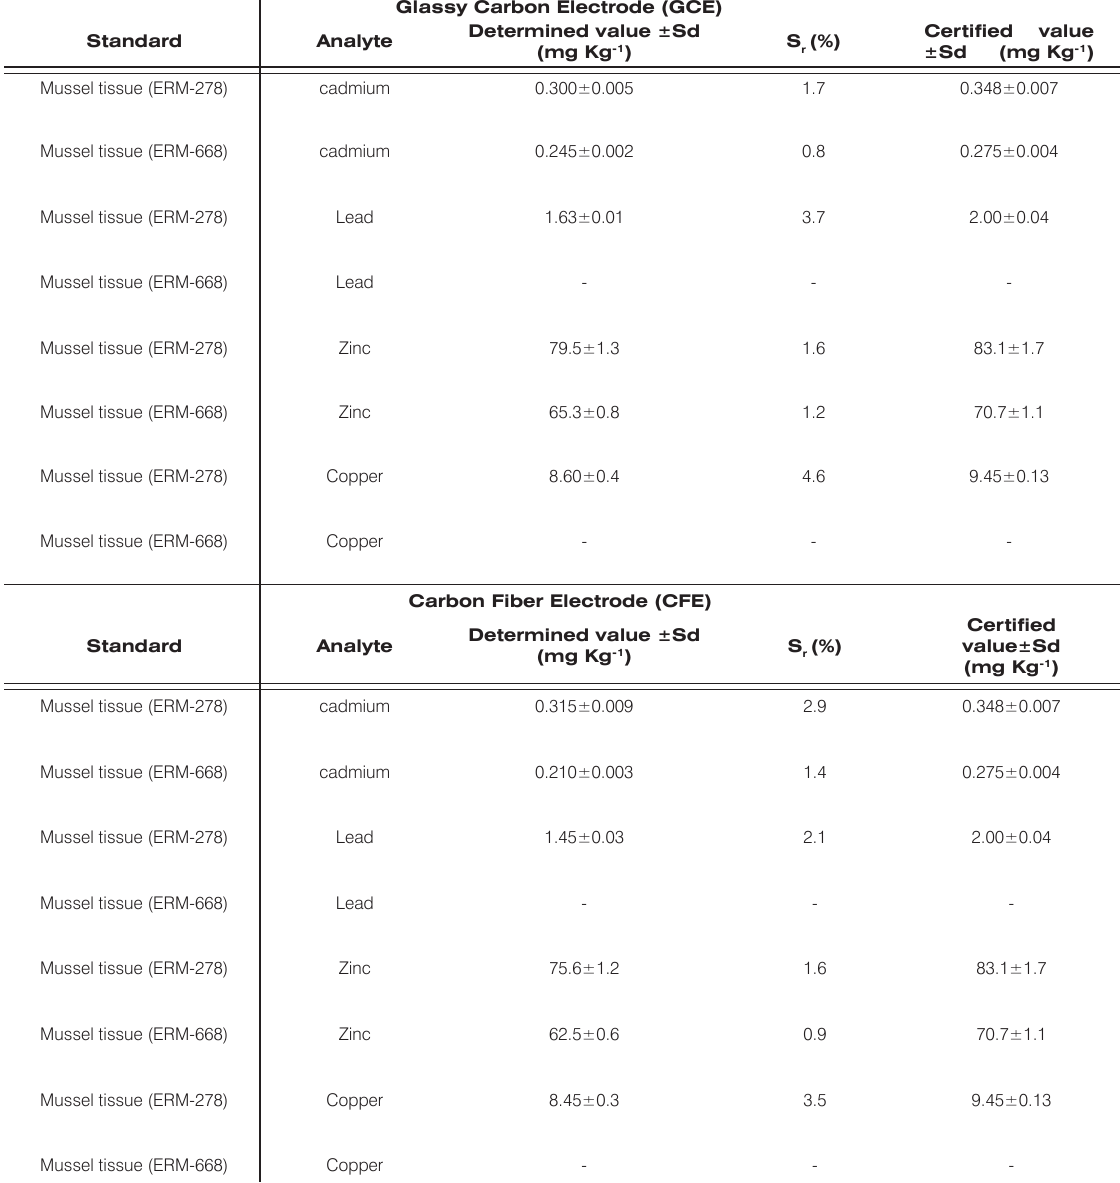
Table 3. Determinations of Cd, Pb, Zn and Cu in mussel tissue certified reference materials ERM-278 and ERM-668.